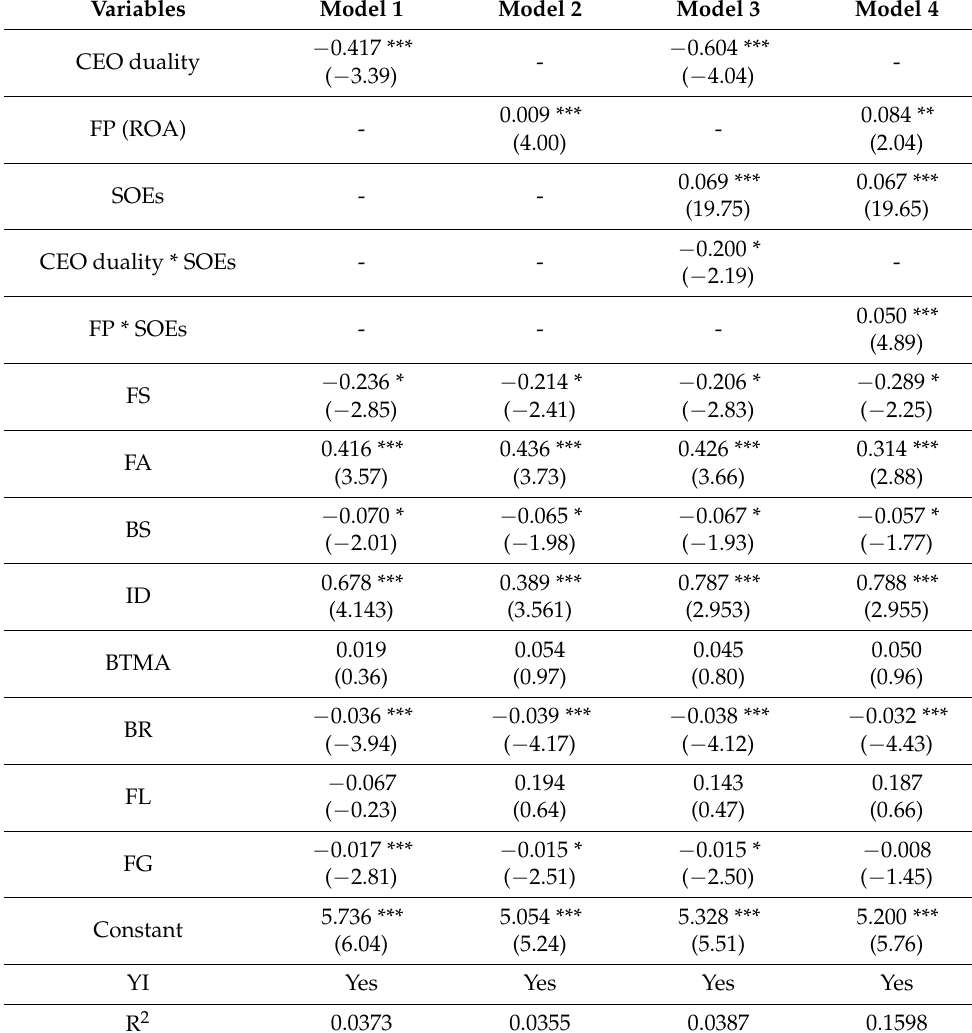
Table 4. Results of impact of CEO duality and financial performance on CSR disclosure, and moder- ating role of